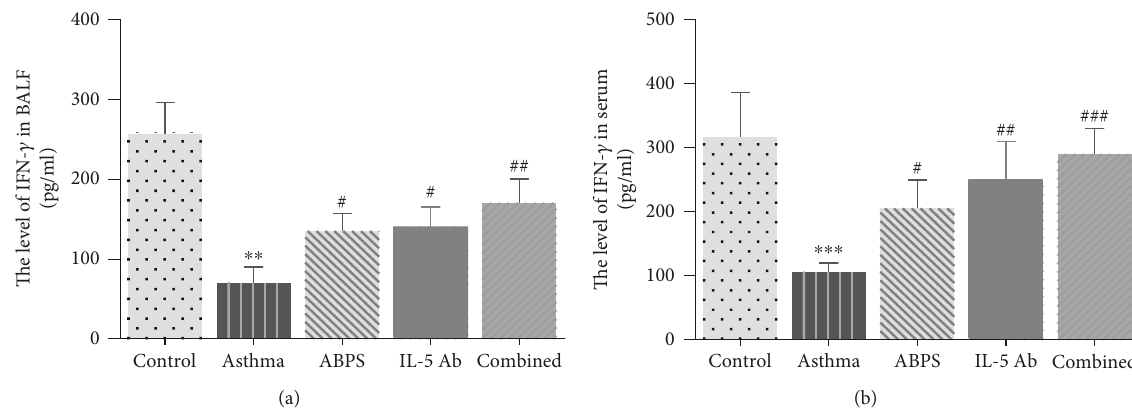
Figure 4: The levels of IFN- γ in BALF (a) and serum (b) of control, asthma group, anti-IL-5 mAb, and ABPS, respectively, or combined treatment group were detected by ELISA. Data was presented as mean Penh +SEM and was from one experiment, with n = 10 mice per group. ∗∗ P < 0 01 , ∗∗∗ P < 0 001 , compared to the control group. # P < 0 05 , ## P < 0 01 , ### P < 0 001 , compared to the asthma group. And the levels of IFN- γ detected from combined treatment group was signi fi cantly higher than individual treatment group. The signi fi cance of the data was evaluated by one-way ANOVA with Bonferroni ’ s multiple comparison test compared to control.